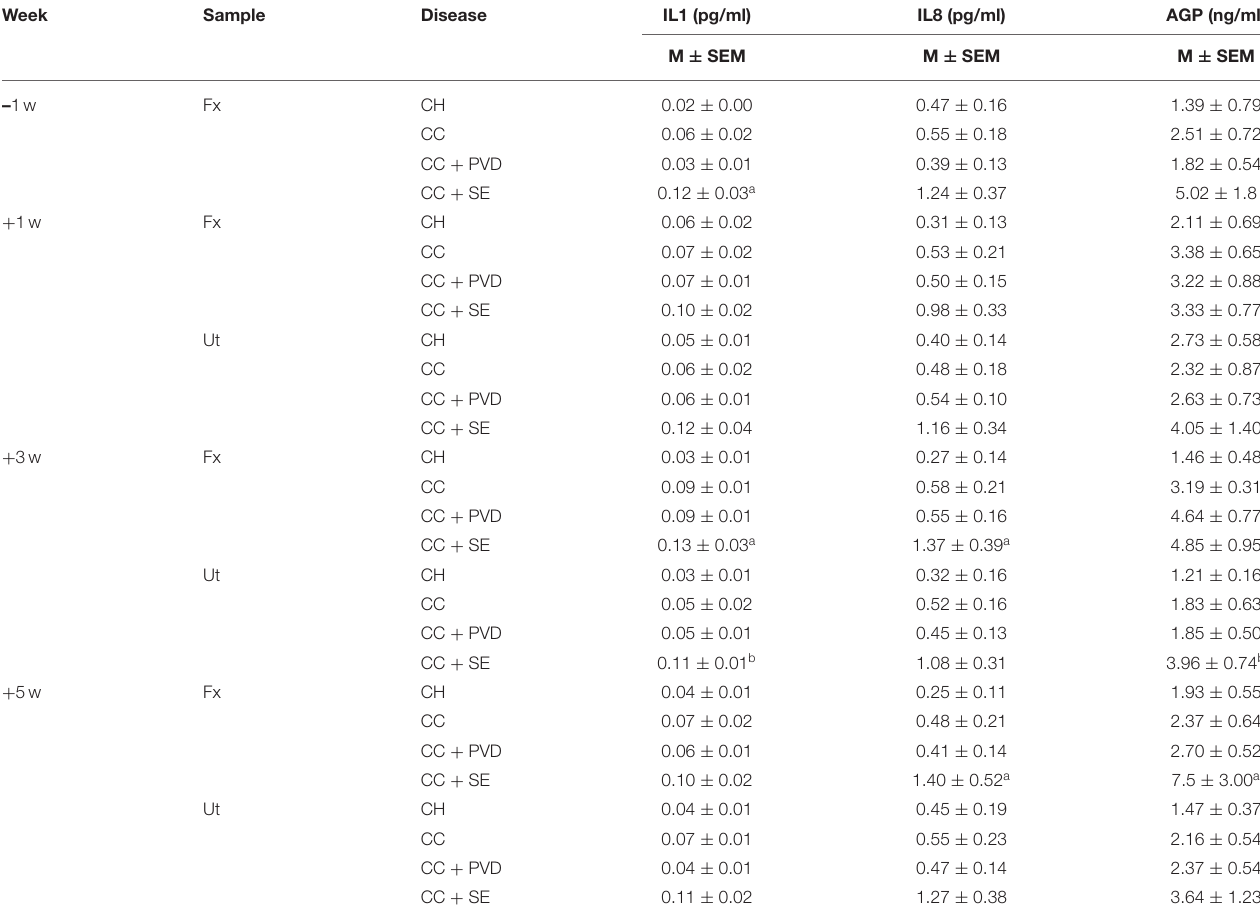
TABLE 1 | Mean ± SEM for AGP, IL1, and IL8 in vaginal fornix and uterine mucus of pre-and post-partum cows ( n = 26) defined as healthy, clinical cervicitis, and clinical cervicitis plus additional uterine disease conditions. Week